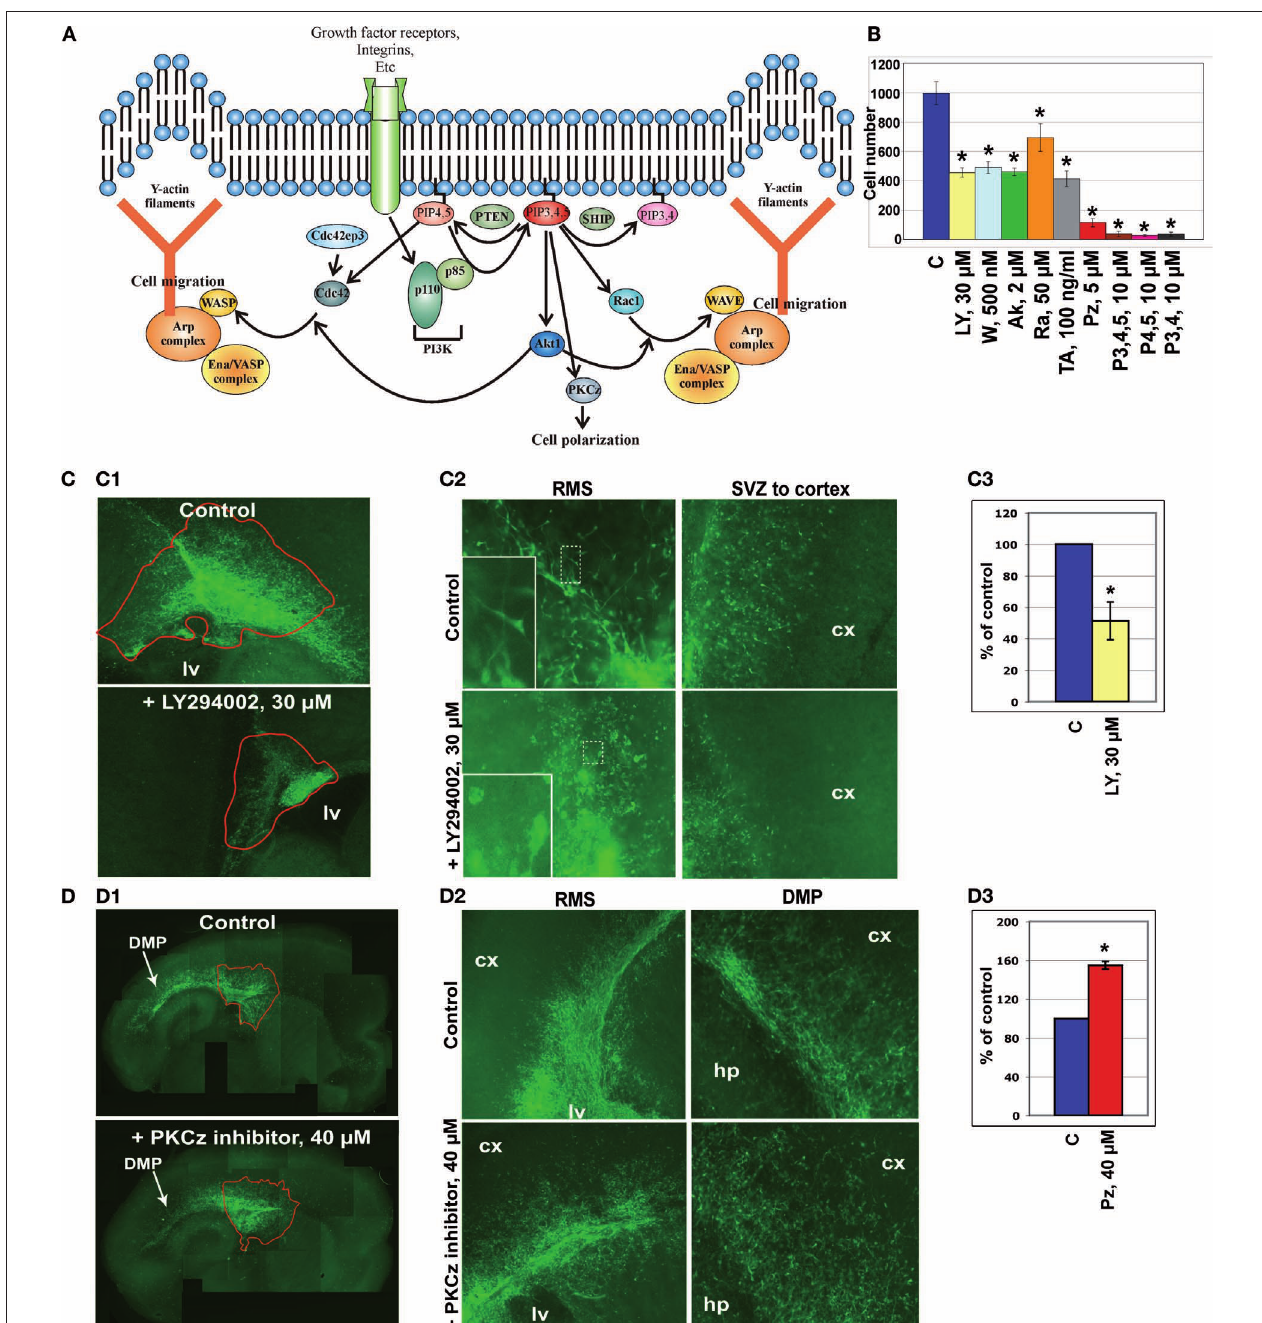
note that LY294002-treated neuroblasts have short or no neurite compared to FIGURE 2 | In vitro analysis of the cytoskeleton pathway. (A) Cytoskeleton control neuroblasts. (C3) Quantifi cation of the LY294002 effect ( n = 5, p < 0.001). pathway involved in neuroblast migration resulting from the microarray data (D1) Effect of PKC ζ inhibitor. (D2) Directionality of neuroblast migration and, analysis. (B) Boyden chamber migrational assay: dissected neuroblasts were therefore, cell polarization is disturbed after PKC ζ inhibitor treatment. Neuroblasts plated on a porous membrane, were allowed to migrate for 24 hours and Tuj1- do not migrate in the streams, but migrate in all directions. This is clearly visible in positive cells were then counted ( p < 0.001). (C,D) Migration analysis in the cortex where there are signifi cantly more neuroblasts in PKC ζ inhibitor-treated organotypic cultures obtained from 5HT3 -EGFP mice. (C1) PI3K inhibitor A slices compared to control slices. (D3) Quantifi cation of the PKC ζ inhibitor effect (LY294002) severely disturbed neuroblast migration. Migration was quantifi ed as ( n = 6, p < 0.005) Abbreviations: Ak – Akt1 inhibitor, C – control, cx – cortex, hp the ratio of the EGFP-positive neuroblast containing area surrounding the SVZ between untreated (control) and treated (inhibitor) slices (obtained from the same sagittal level) after 4 days in culture ( n ≥ 5 slices per condition). (C2) Higher magnifi cations of RMS and SVZ in control and PI3K inhibitor-treated slices. Insets: